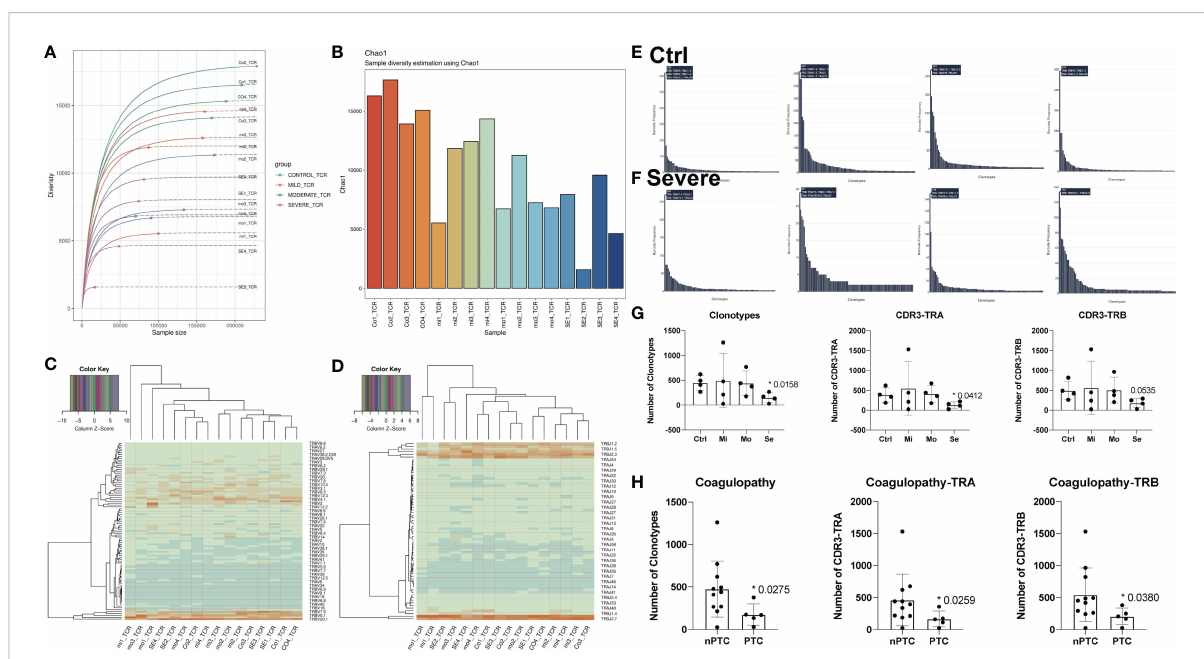
FIGURE 2 The differences of T-cell clonity in TBI patients. (A) Clonotype richness of TCR in different samples. (B) Chao1 index of TCR in different samples. (C, D) The relative expression of V and J genes in different groups. (E, F) The number of clonotypes of TCR genes in the control and severe group. (G) The quanti fi cation of clonotypes CD3-TRA and CD3-TRB in different TBI groups. (H) The quanti fi cation of clonotypes CD3-TRA and CD3-TRB between nPTC and PTC